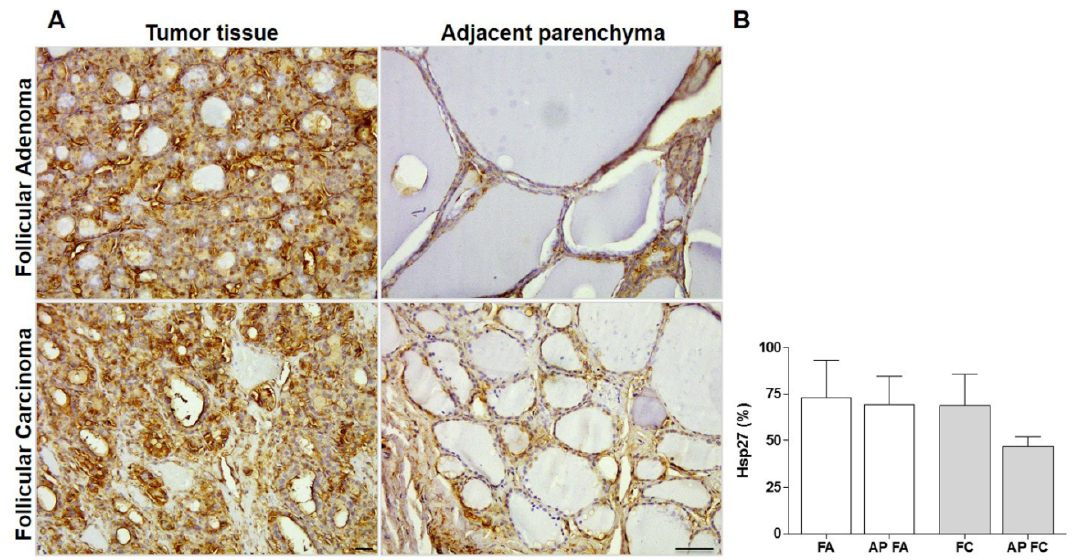
Figure 1. Hsp27 Immunohistochemistry. ( A ) Representative images of immunohistochemical results for Hsp27. Magnification 200 × ; scale bar 100 µ m. ( B ) The histogram shows statistical results for the immunohistochemical evaluation for Hsp27 in follicular adenoma (FA), adjacent parenchyma of follicular adenoma (AP FA), follicular carcinoma (FC) and adjacent parenchyma of follicular carcinoma (AP FC). Data are presented as mean +SD.